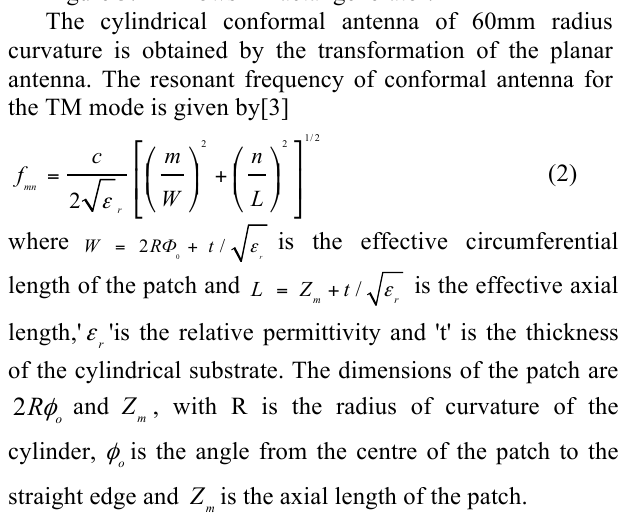
Figure 3: Minkowski fractal generator.